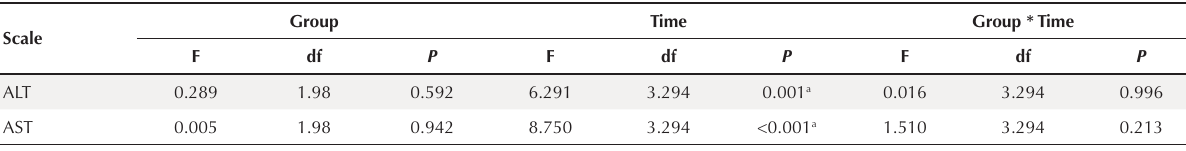
Table 2. Effects of group (control and intervention), time (before, first month, second month, and third month after treatment), and their interaction group*time